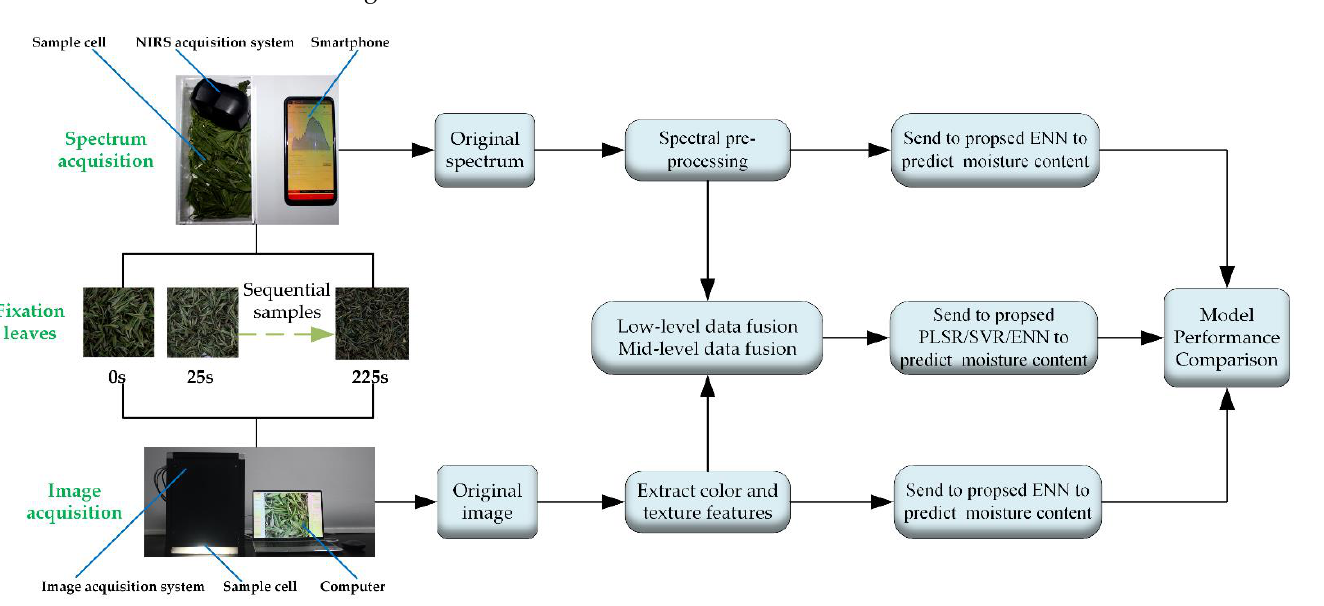
Figure 1. Flow chart of this study.